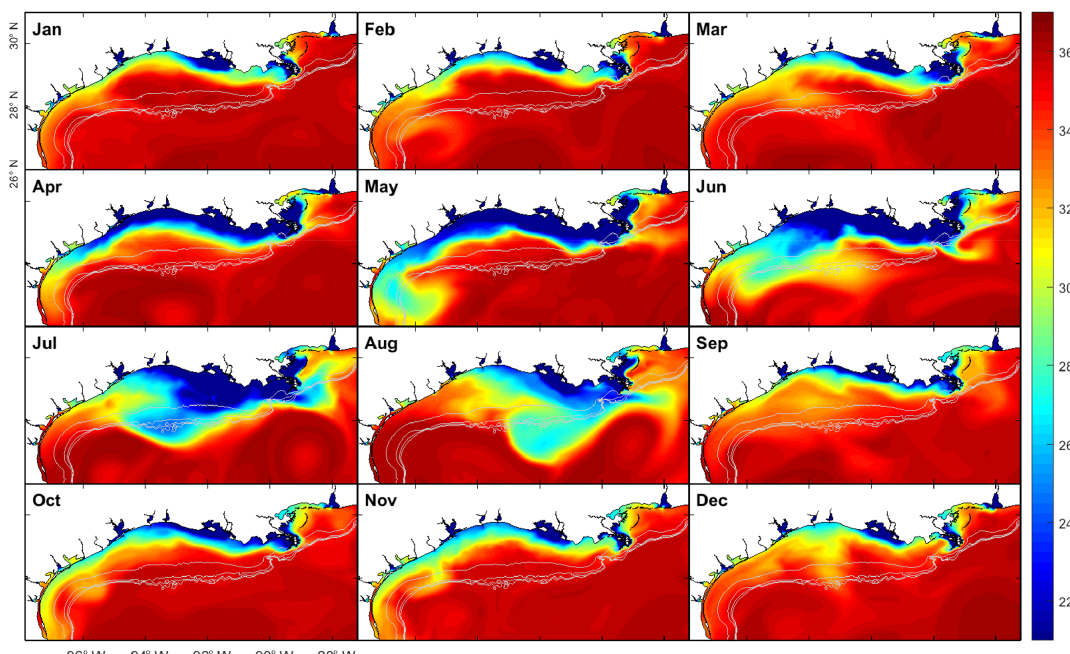
Figure 10. The modeled monthly mean surface salinity in 2008, with the grey contour lines denoting depth contours of 50, 100, 150, and